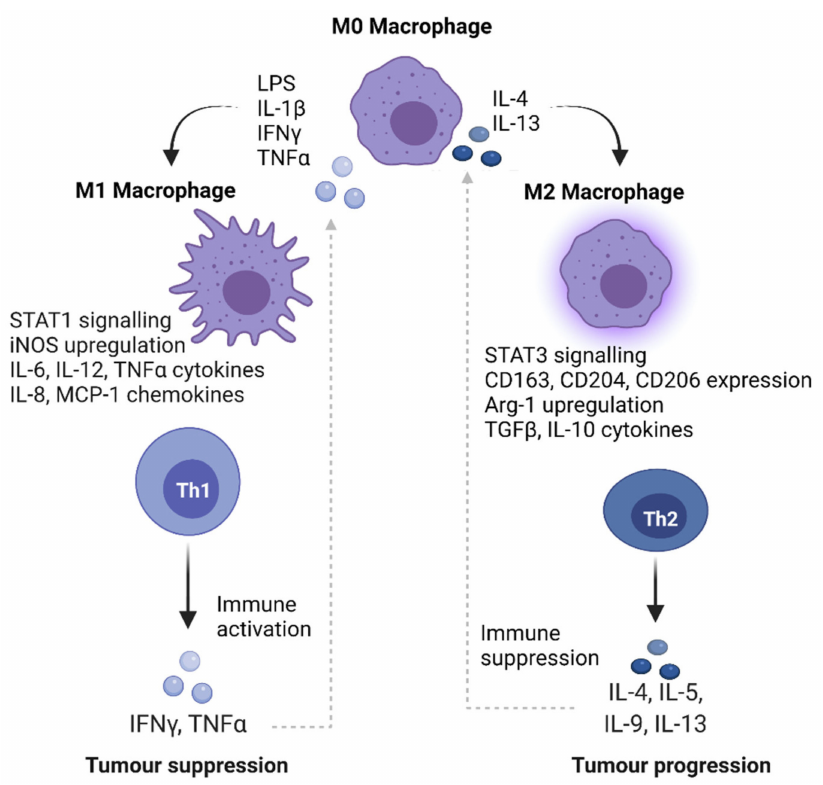
Figure 3. The role of macrophage phenotype and immune system signalling in DMGs. Macrophages are the predominant immune cell within the DMG microenvironment, where they exhibit a basal M0 phenotype. M0 macrophages are capable of being polarised to either a classically activated, proinflammatory M1 or an alternatively activated M2 phenotype depending entirely on the inflam- matory environment encountered. Macrophages are transformed into an M1 phenotype by exposure to proinflammatory LPS, IL-1 β , IFN γ or TNF α , which activates STAT1 signalling and therefore upregulates iNOS expression and the release of cytokines such as IL-6, IL-12 and TNF α along with increased production of chemokines such as IL-8 and MCP-1. Alternately, macrophages are polarised to an M2 phenotype following exposure to the cytokines IL-4 and IL-13, inducing STAT3 signalling and therefore the upregulation of cell surface markers CD 163, CD204 and CD206 as well as the release of Arg-1, TGF β and IL-10. The activation of M1 macrophages promotes immune activation through the Th1 T cell response and subsequent release of proinflammatory IFNg and TNFa, leading to DMG tumour suppression and ongoing macrophage M1 activation. In contrast, M2 macrophages suppress the immune response through Th2 T cell activation, promoting DMG progression through establishing a tumour microenvironment which favours M2 macrophage